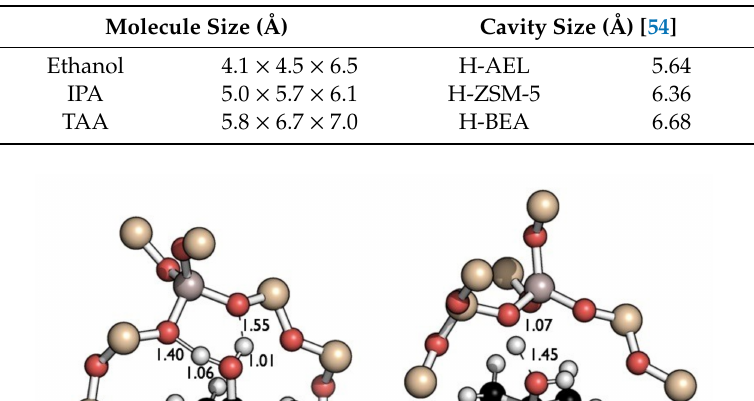
Table 2. Measured molecule size of ethanol, IPA, TAA, and zeolite cavity size. The cavity size of a zeolite was defined as the maximum diameter of a sphere that can be included in the zeolite [54]. A description of the measurement of molecule size is provided in Figure S1.